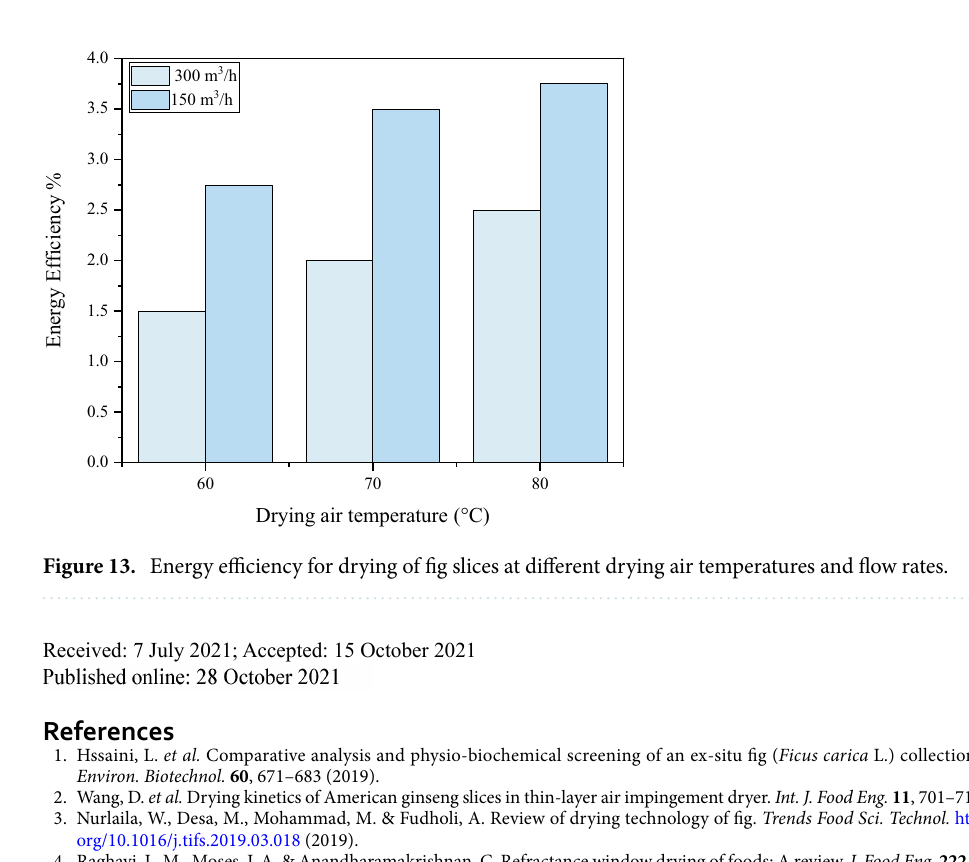
Figure 12. Energy consumption and specific energy consumption (SEC) during convection solar drying of fig slices at different aero-thermal conditions.